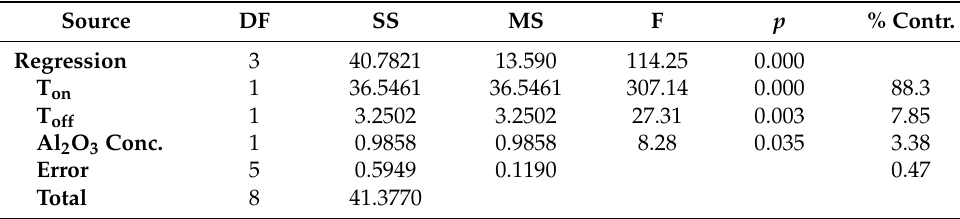
Table 5. ANOVA for Table 5. ANOVA for RLT.